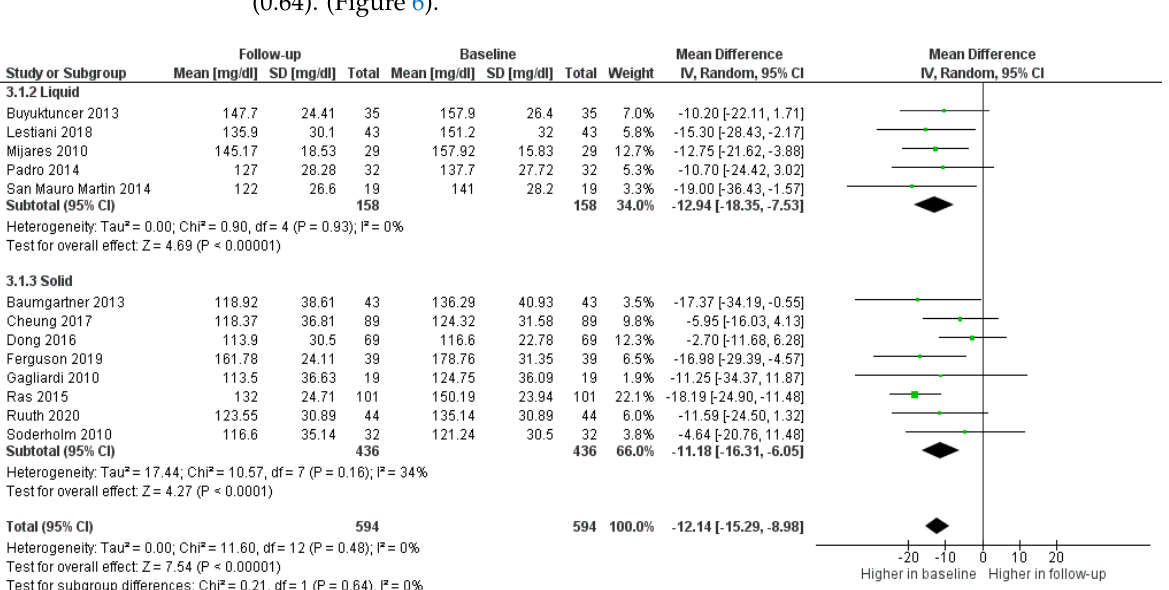
Figure 5. Forest plot comparing different ranges of LDL-c among participants in the treatment groups.